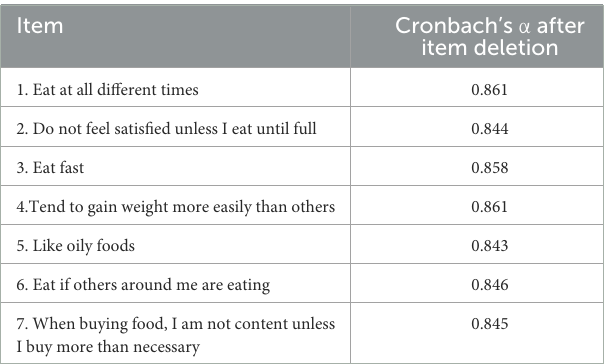
TABLE 3 Corrected item -total correlation of the simplified Chinese version of the EBS short